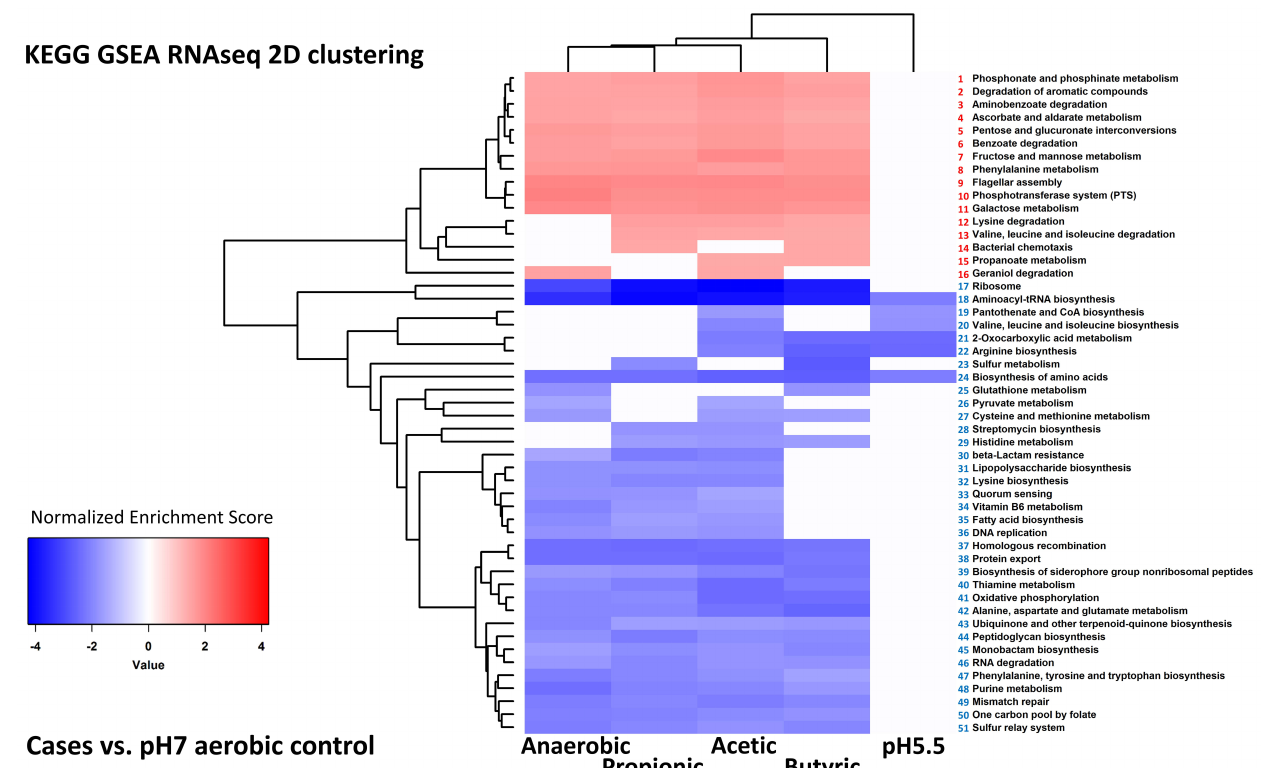
Figure 3. Clustering of KEGG pathways identified by GSEA analysis of RNAseq data. This figure shows an example 2D hierarchical clustering of GSEA normalized enrichment scores, from KEGG pathways enriched onto differential gene expression signatures of cultures grown anaerobically, or aerobically plus acetic acid, propionic acid and butyric acid, vs. aerobic control cultures at pH 7. All four conditions are shown in Figure S3. Sixteen KEGG pathways were found to be enriched/activated in cases vs. controls, and are listed by numbers 1 to 16 as follows: (1) phosphonate and phosphinate metabolism, (2) degradation of aromatic compounds, (3) aminobenzoate degradation, (4) ascorbate and aldarate metabolism, (5) pentose and glucuronate interconversions, (6) benzoate degradation, (7) fructose and mannose metabolism, (8) pheny- lalanine metabolism, (9) flagellar assembly, (10) phosphotransferase system (PTS), (11) galactose metabolism, (12) lysine degradation, (13) valine, leucine and isoleucine degradation, (14) bacterial chemotaxis, (15) propanoate metabolism and (16) geraniol degradation pathway. Another thirty five KEGG pathways were enriched in the aerobic pH 7 controls vs. two or more conditions; they are numbered 17 to 51 as follows: (17) ribosome, (18) aminoacyl-tRNA biosynthesis, (19) pantothenate and CoA biosynthesis, (20) valine, leucine, and isoleucine biosynthesis, (21) 2-oxocarboxylic acid metabolism, (22) argi- nine biosynthesis, (23) sulphur metabolism, (24) biosynthesis of amino acids, (25) Glutathione metabolism, (26) pyru- vate metabolism, (27) cysteine and methionine metabolism, (28) streptomycin biosynthesis, (29) histidine metabolism, (30) β -lactam resistance, (31) lipopolysaccharide biosynthesis, (32) lysine biosynthesis, (33) quorum sensing, (34) vitamin B6 metabolism, (35) fatty acid biosynthesis, (36) DNA replication, (37) homologous recombination, (38) protein export, (39) biosynthesis of siderophore group non-ribosomal peptides, (40) thiamine metabolism, (41) oxidative phosphorylation, (42) alanine, aspartate and glutamate metabolism, (43) uniquinone and other terpenoid-quinone biosynthesis, (44) peptido- glycan biosynthesis, (45) monobactam biosynthesis, (46) RNA degradation and (47) phenylalanine, tyrosine and tryptophan biosynthesis, (48) purine metabolism, (49) mismatch repair, (50) one carbon pool by folate and (51) sulphur relay